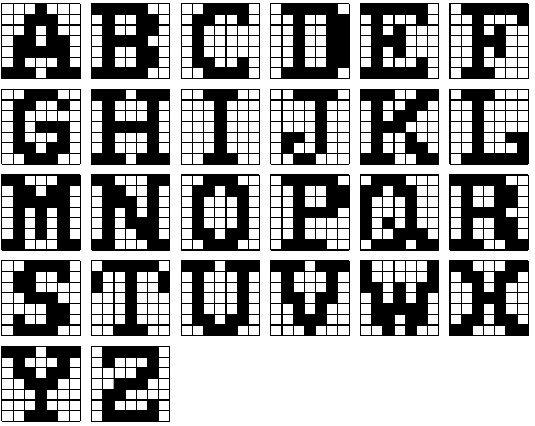
Figure 2. 7 × 7 original alphabet images.